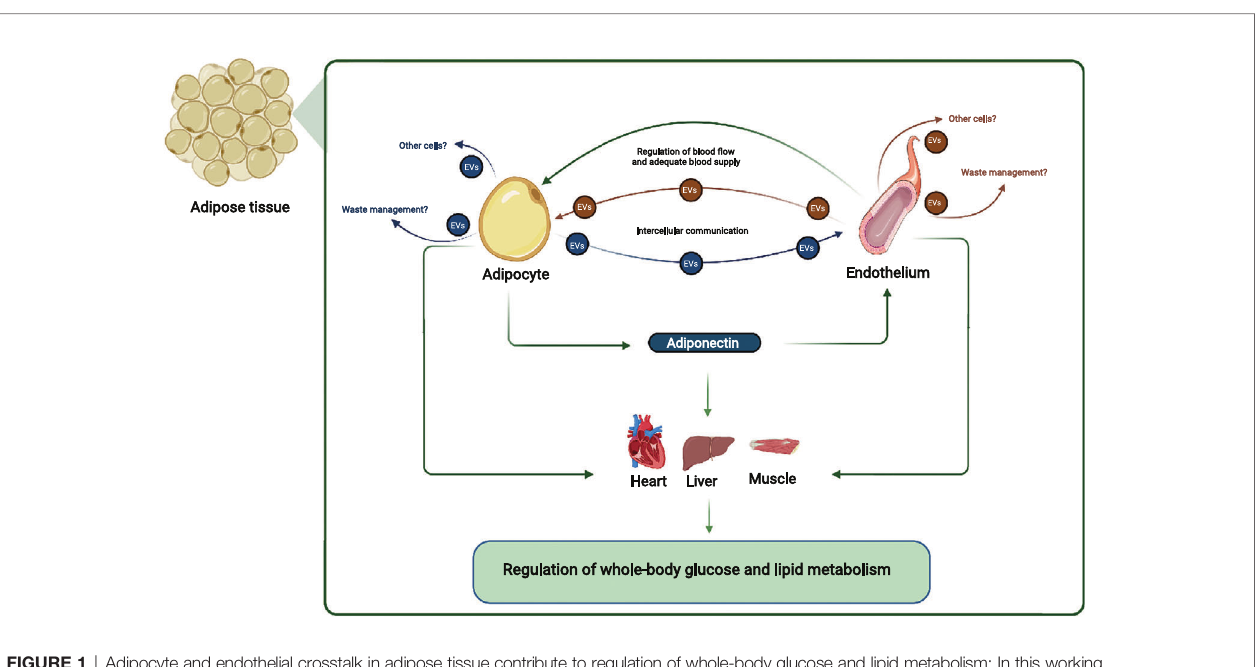
FIGURE 1 | Adipocyte and endothelial crosstalk in adipose tissue contribute to regulation of whole-body glucose and lipid metabolism: In this working hypothesis, endothelial cells regulate blood fl ow adequately to adipocytes, which secrete adiponectin that communicate locally with endothelial cells and with distant organs such as muscle, liver, and heart. Adiponectin stimulates EV secretion from endothelial cells, ensuring their health e.g. through cellular waste management, and stimulates muscle, liver, and heart metabolism, improving systemic metabolism. EVs from adipocytes and endothelial cells may also target other cell types. Other adipocyte-derived factors, and overall endothelial health also contributes to regulation of whole-body glucose and lipid metabolism. Figure created with